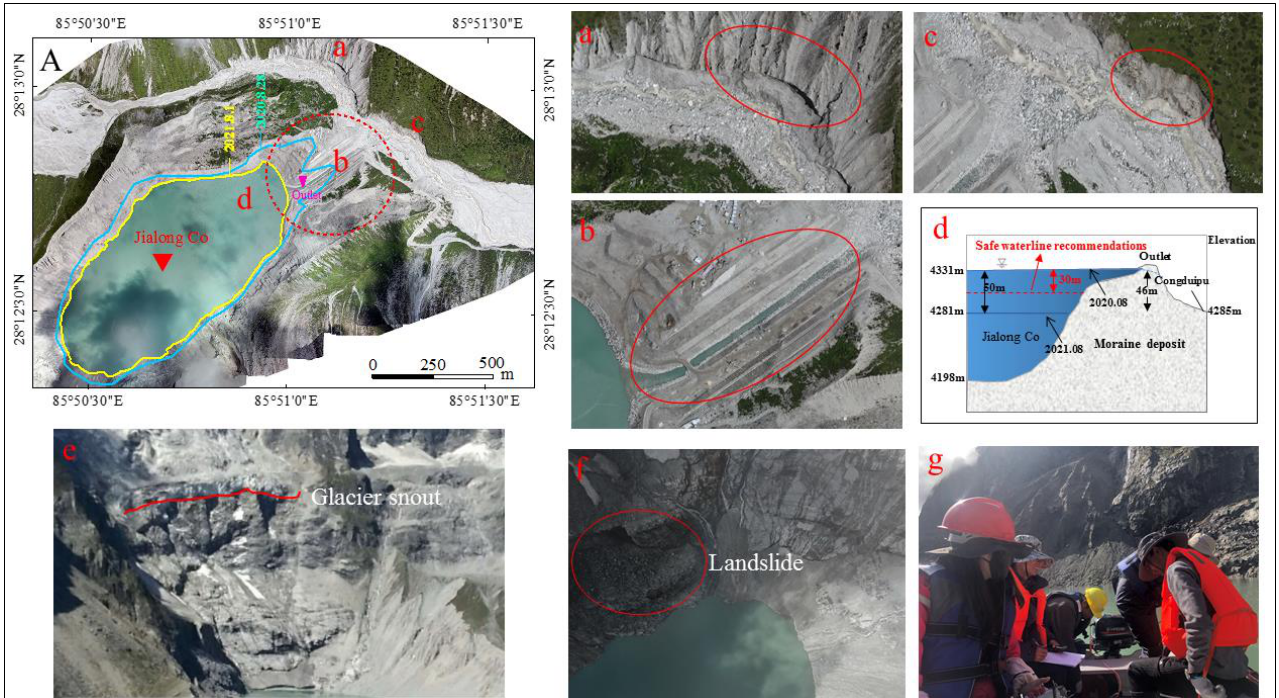
Figure 10. Unmanned aerial survey images of Jialong Co glacial lake, including a general overview ( A ), upstream meltwater erosion banks ( a ), engineering management area ( b ), outlet erosion banks ( c ), profile around the outlet ( d ), the snout of the mother glacier ( e ), landslide connected to the lake ( f ), and manual bathymetric operations ( g ).